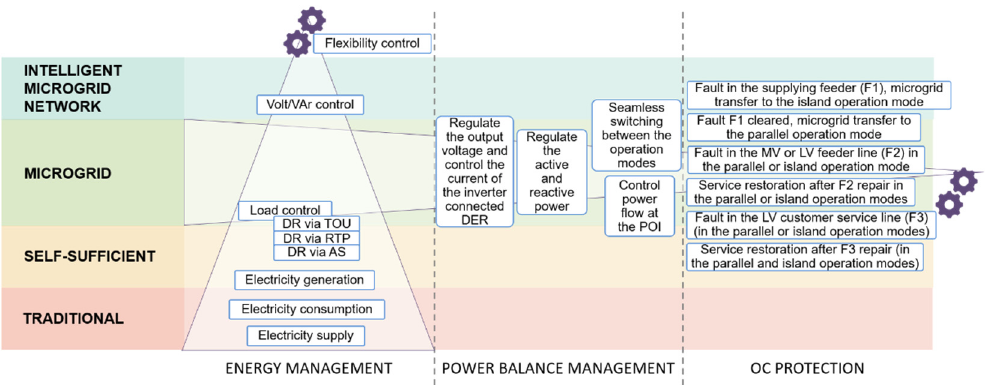
Figure 7. Analysis of the electricity distribution network evolution by the high-level use case stud-